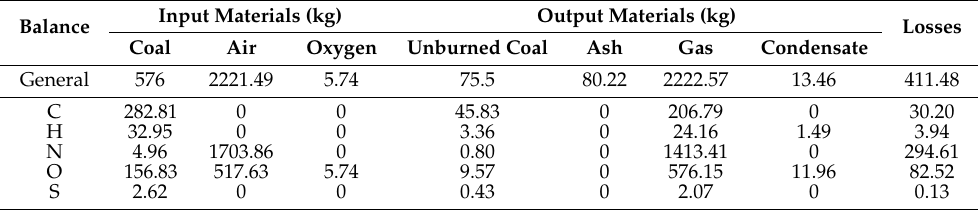
Table 2. The general and atomic balance values obtained from the first experiment calculations. Balance